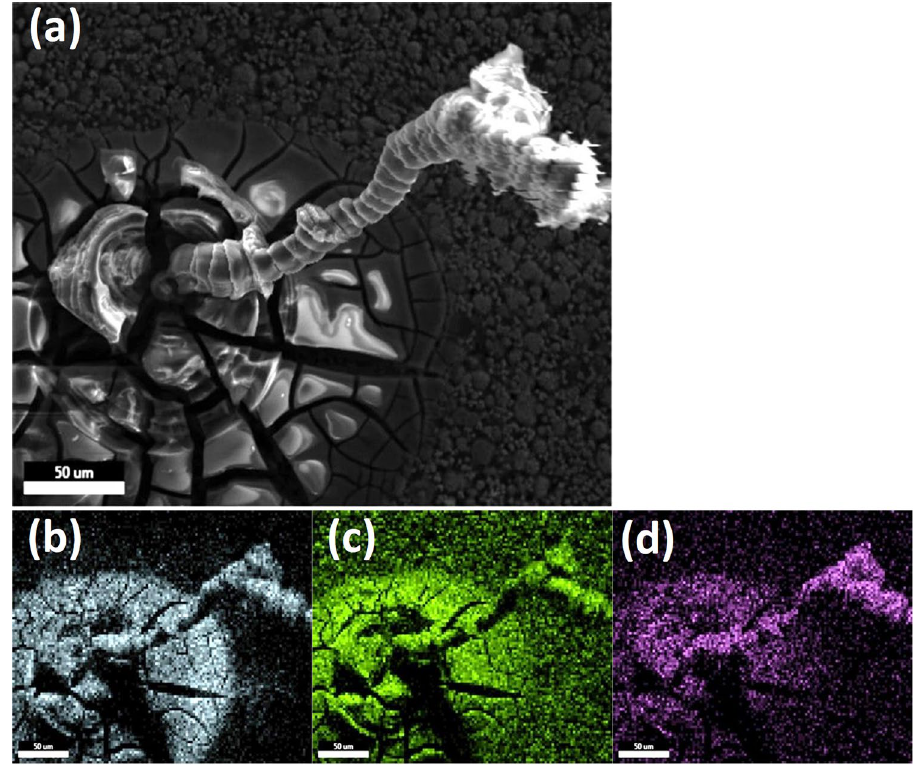
Figure 6. ( a ) SEM image of the stalactite-like crystallite; EDX element mapping for ( b ) aluminum, ( c ) oxygen, ( d ) sulphur of the crystallite; humidity φ = 80% for t = 18